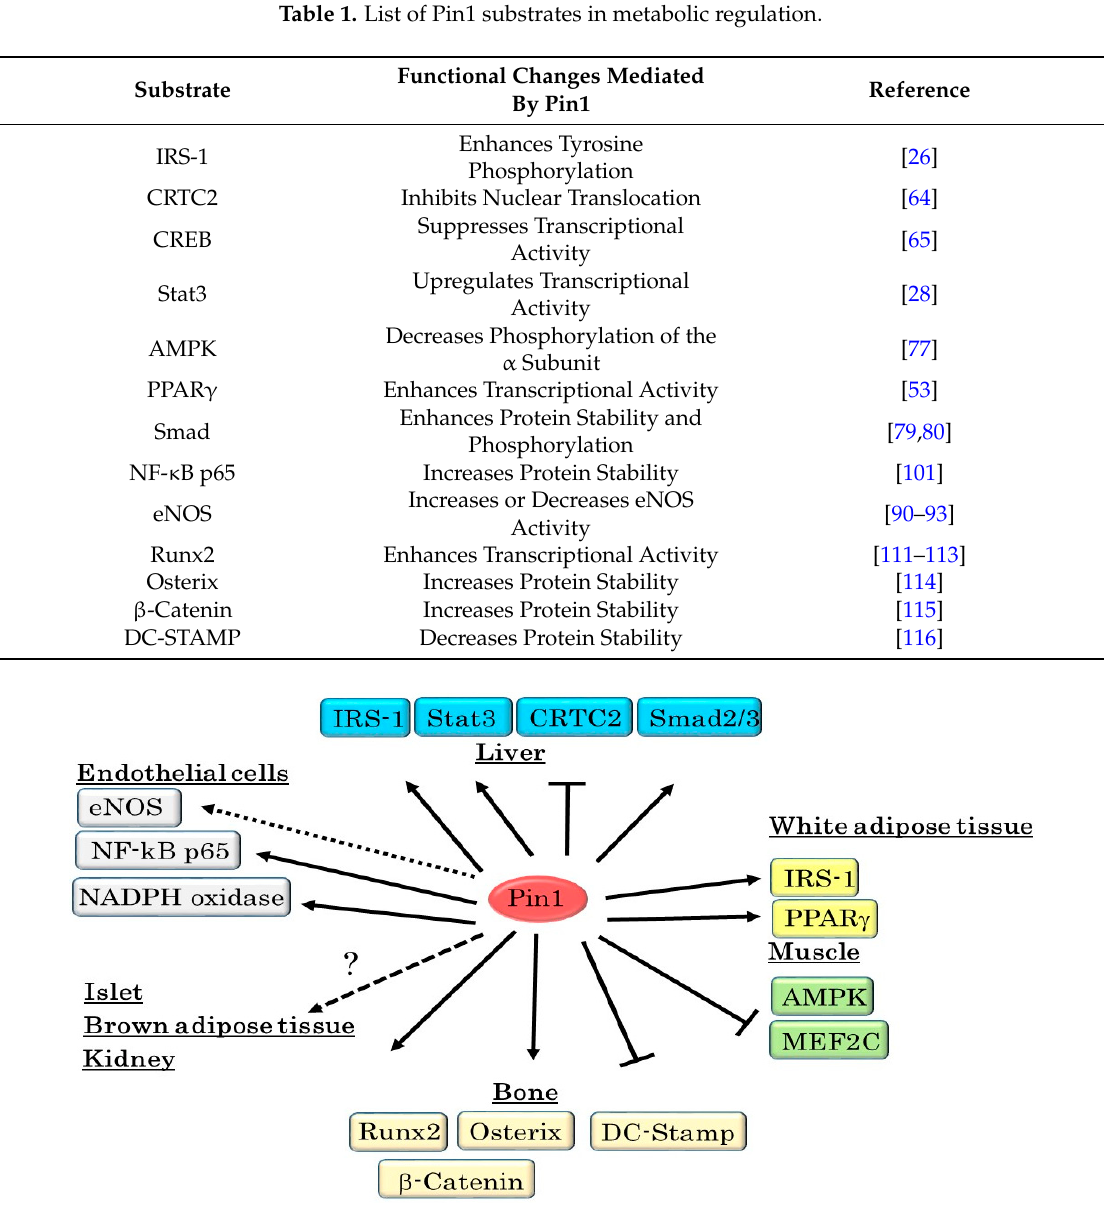
Figure 5. Pin1 regulates multiple signal transductions in metabolic organs. Pin1 enhances insulin signaling through binding to IRS-1 and suppresses gluconeogenesis by associating with CRTC2, CREB and Stat3 in the liver. In addition, Pin1 increases liver fibrosis through regulation of the TGF-Smad pathway. In adipocytes, upregulation of insulin signaling by Pin1 leads to the induction of lipid synthesis and obesity. However, Pin1 suppresses myogenesis via degradation of MEF2C and decreases fatty acid synthesis by inhibiting AMPK phosphorylation. Pin1 also enhances osteoblast formation and suppresses osteoclast fusion, thereby preventing osteoporosis. Furthermore, Pin1 is involved in vascular inflammation via the stabilization of p65 protein. Thus, while Pin1 clearly operates as a master regulator of metabolism, its roles in certain tissues, such as pancreatic islets, the kidney, and brown adipose, remain to be determined. ( ↑ ): Pin1 positively regulates functions of substrates; (T): Pin1 negatively controls functions of substrates; (dotted lines): The regulation by Pin1 have remained undetermined; (?): There are no reports which elucidate the roles of Pin1 in these tissues.